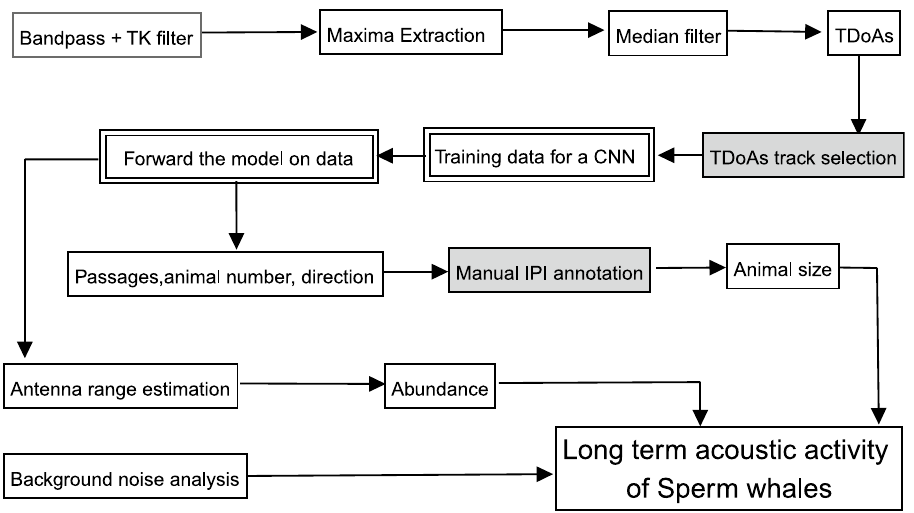
Figure 6. Summary diagram of the analysis. Gray boxes: semi-manual process. Double line: deep learning